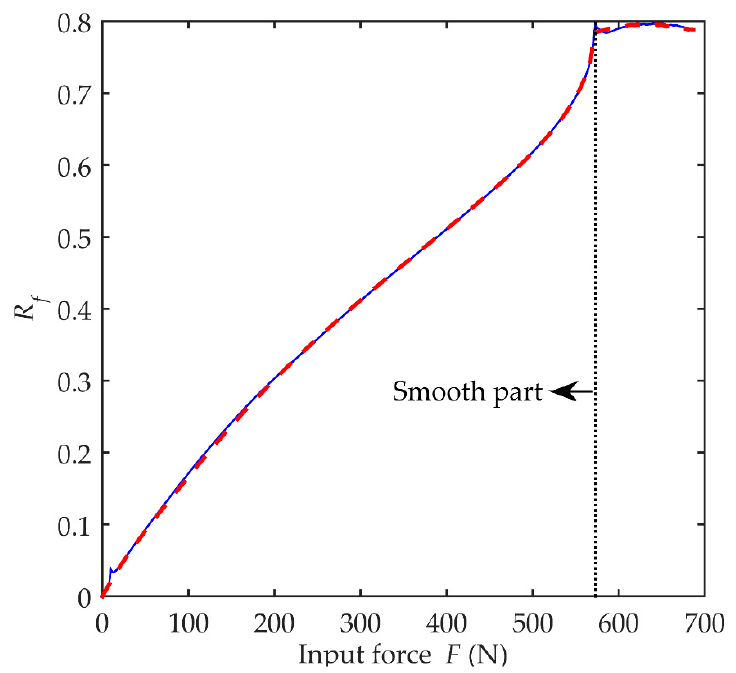
Figure 5. The trace of R f _ Lc 0 (solid blue line) simulated by the VCBS model, and the trace of ˆ R f _ Lc 0 (red dashed line) predicted by the surrogate model.